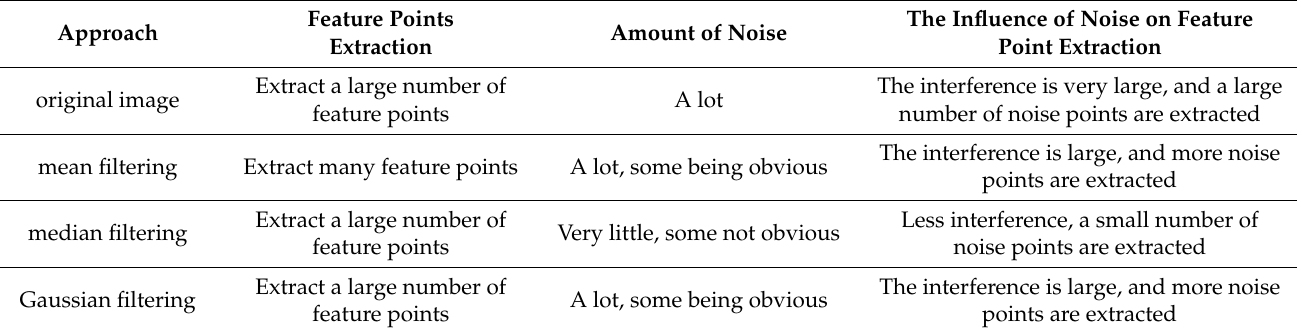
Table 1. Performance comparison of filtering